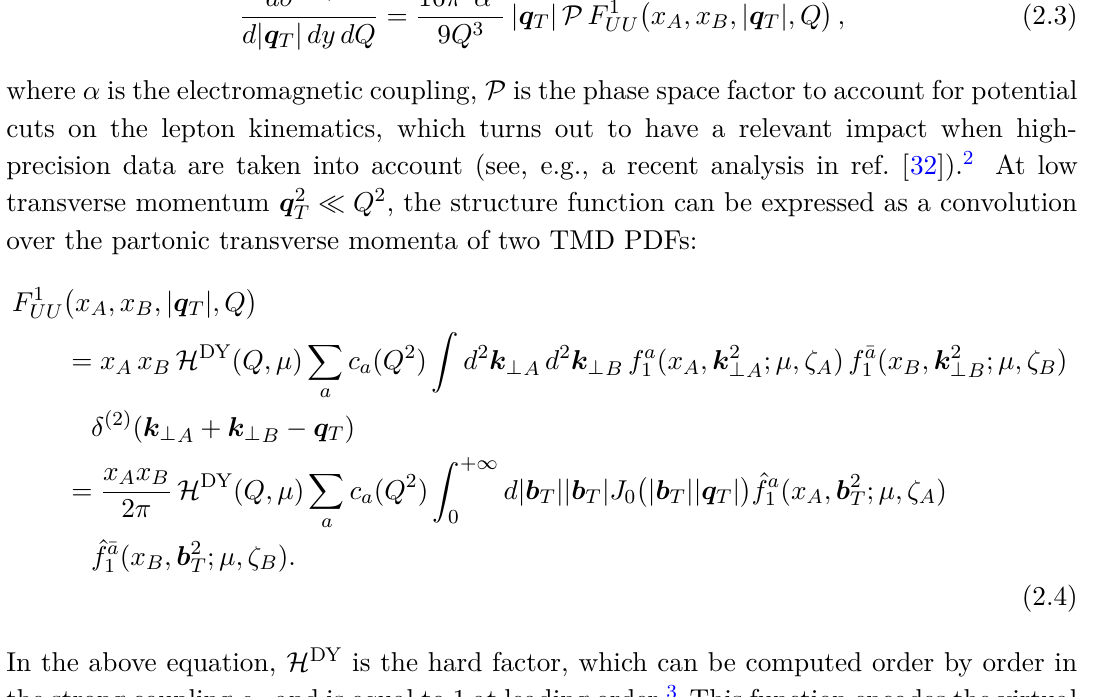
and k (not measured). They produce ⊥ A ⊥ B = k + k with respect to the T ⊥ A ⊥ B